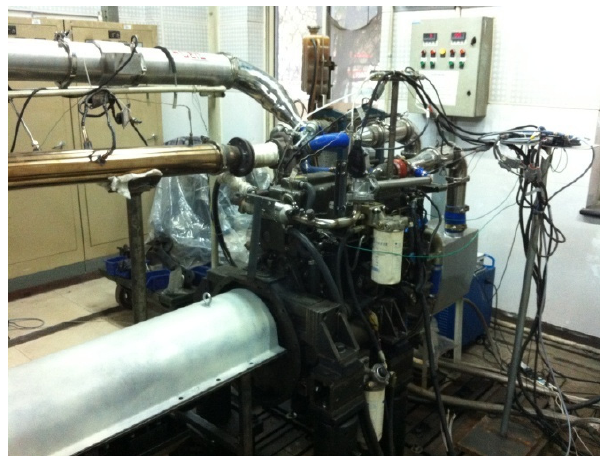
Figure 10. Test bench of YC4E170-31 diesel